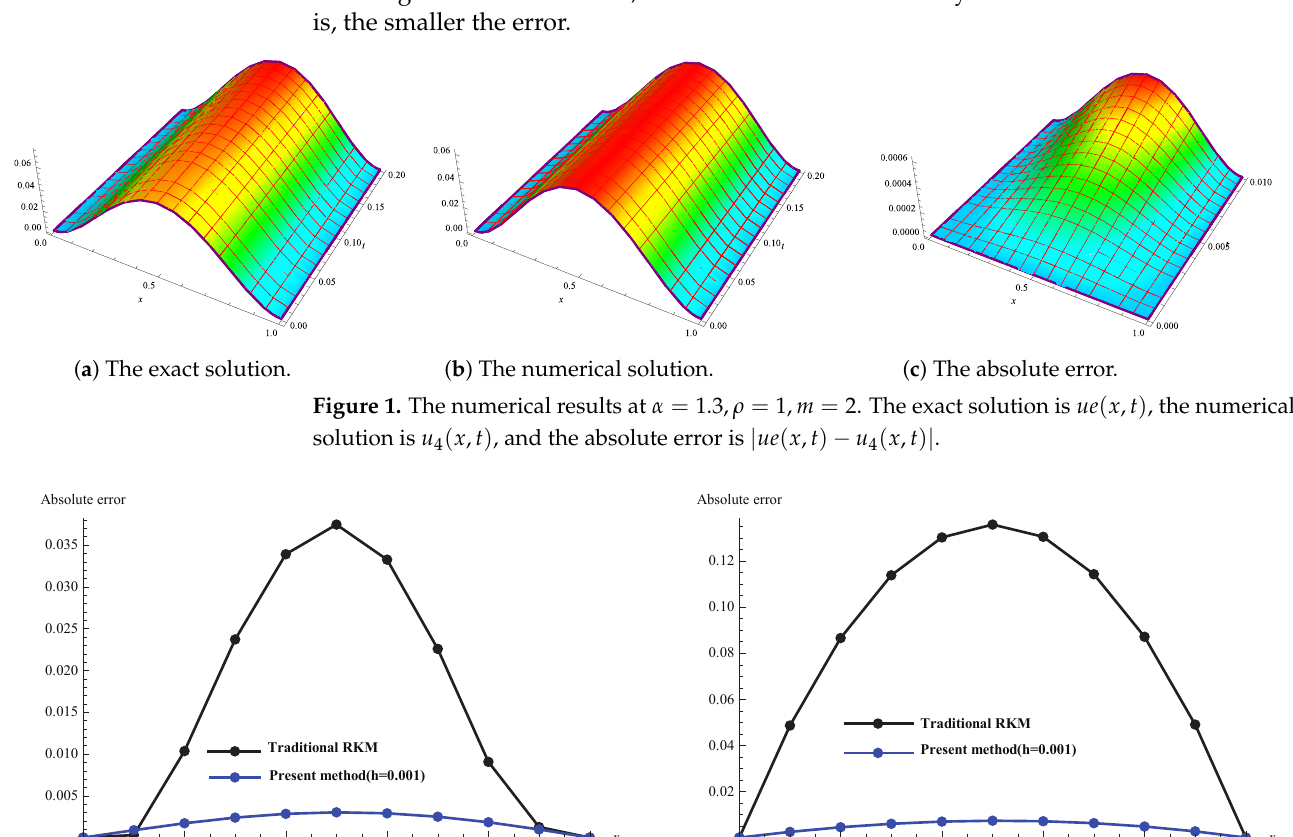
Figure 2. Comparison of the absolute errors for two reproducing kernel methods at t = 0.01 and different reproducing kernel spaces. ( a ) The absolute errors in reproducing kernel space l ( α = 1, ρ = 1, andm = 2). ( b ) The absolute errors in reproducing kernel space 2 ( α = 1